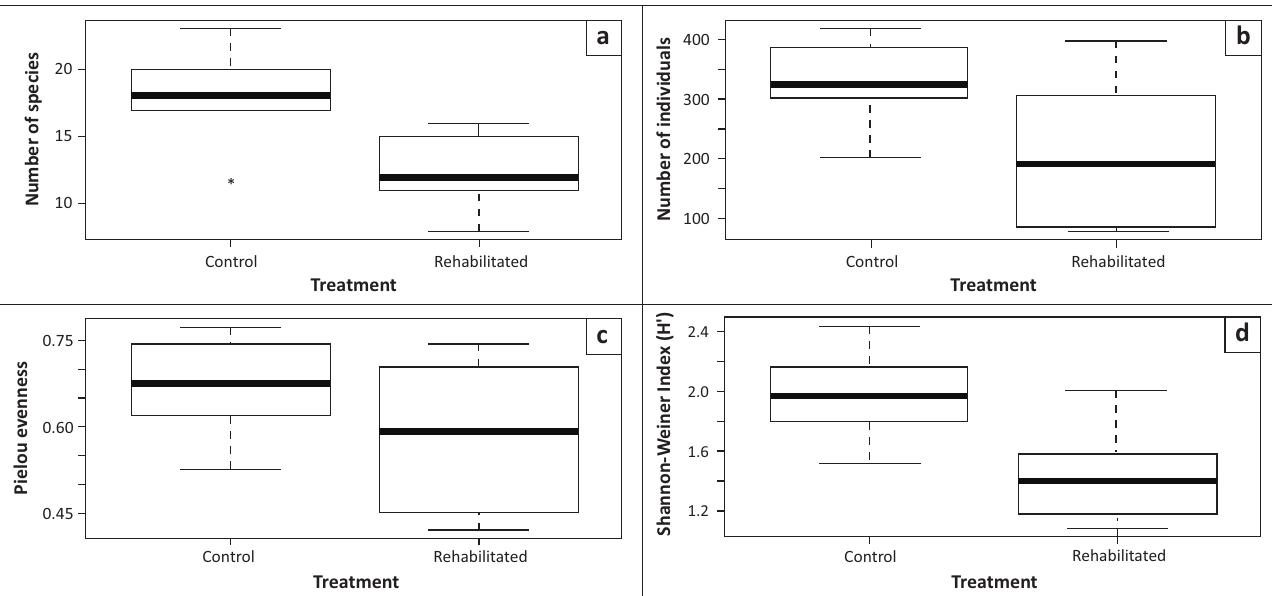
FIGURE 1: Box plots of ant diversity in the control and rehabilitated sites on Rietvlei Nature Reserve, showing (a) the number of species, (b) the number of individuals, (c) the Pielou evenness (J’) and (d) the Shannon–Weiner Index